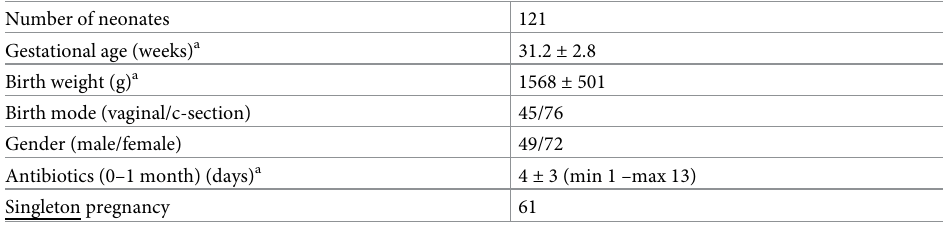
Table 1. Characteristics of the premature neonates included in the